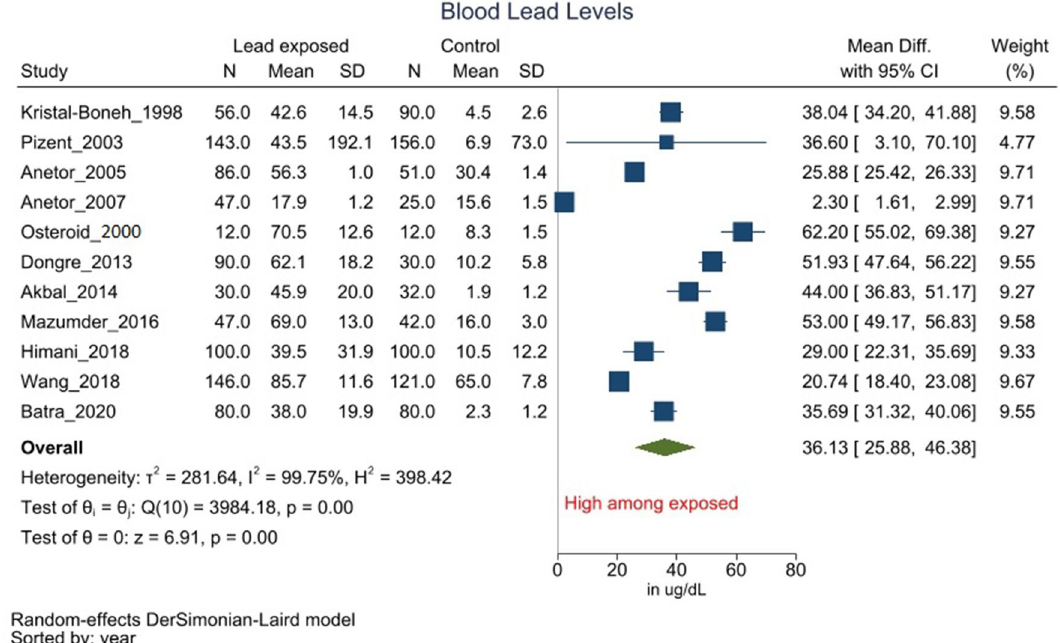
Figure 2. Forest plot for association between occupational Pb exposure and Blood lead levels. (Legends/ footnotes): forest plot revealing the group mean differences of blood lead levels (BLL) in µg/dl between the occupationally Pb exposed workers and control participants (i.e. without obvious Pb exposure). The square and whisker (horizontal lines) represent respectively the mean difference and 95% confidence interval of individual studies. The length and width of the diamond indicate the pooled mean difference and 95% confidence interval derived from random-effect